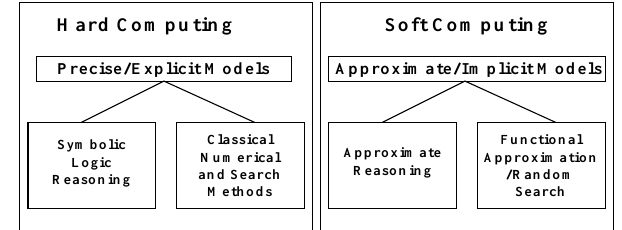
Fig. 3. Hard and Soft